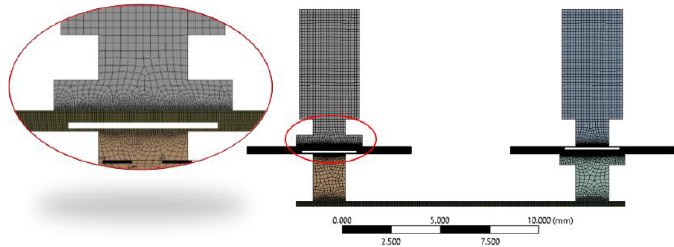
Figure 5. Mesh of the fluid inside the piezoelectric hydraulic pump.